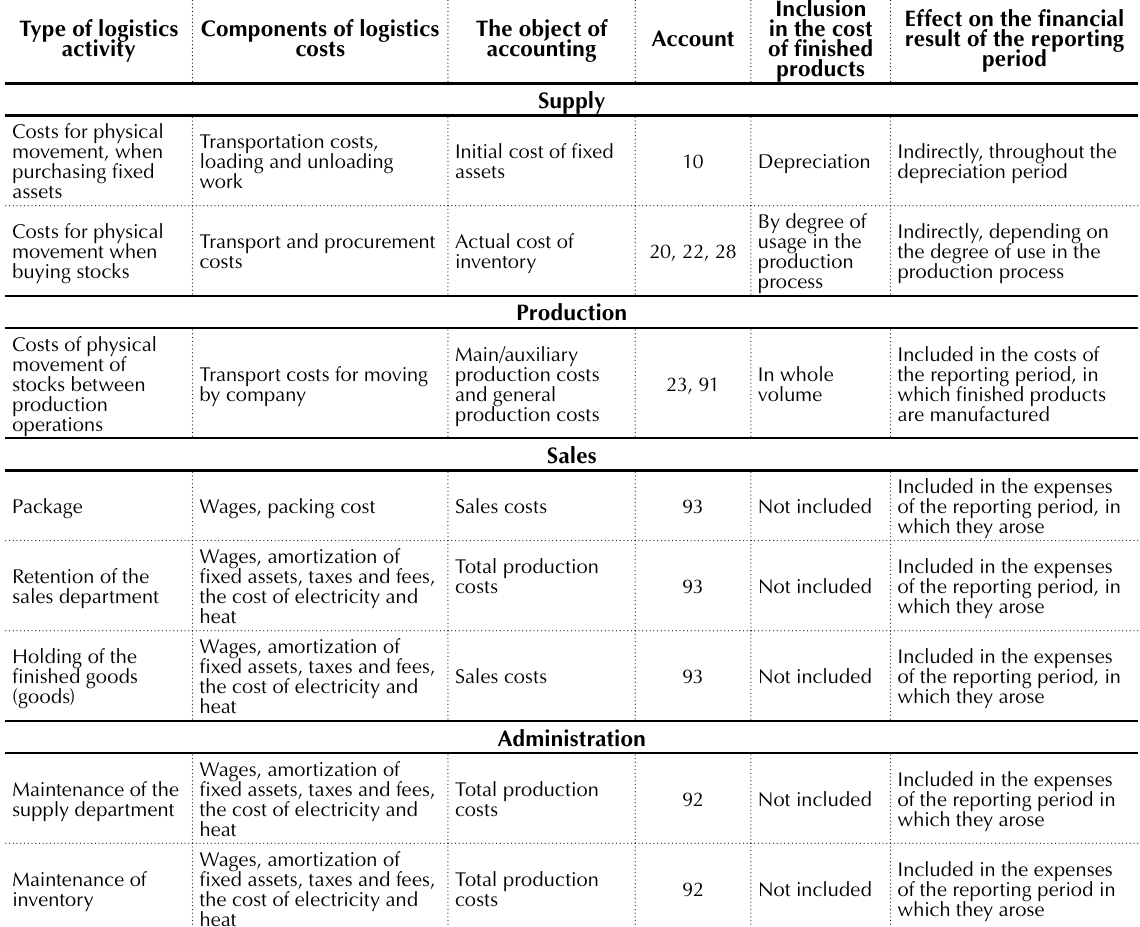
Table 3. Accounting identification of logistics costs in the process